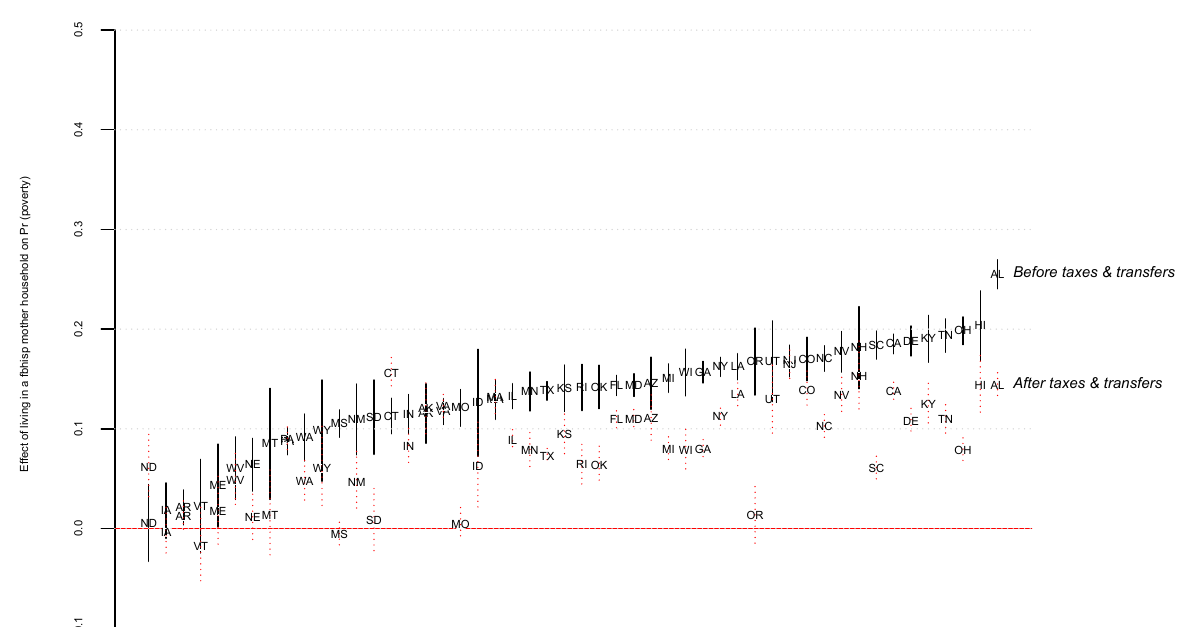
Figure 8: Foreign-born Hispanic penalty: effects of living in with a foreign-born Hispanic head on Pr (poverty) before and after taxes and transfers (2012–2016 CPS). Adjustments for SNAP, SSI, and TANF underreporting were made using the Urban Institute Transfer Income Model (TRIM). Effects represent coefficients from varying slope linear probability models predicting SPM poverty. The nonvarying slopes in the model are year fixed effects and a control for metropolitan and/or nonmetropolitan status. States are indicated by their postal code